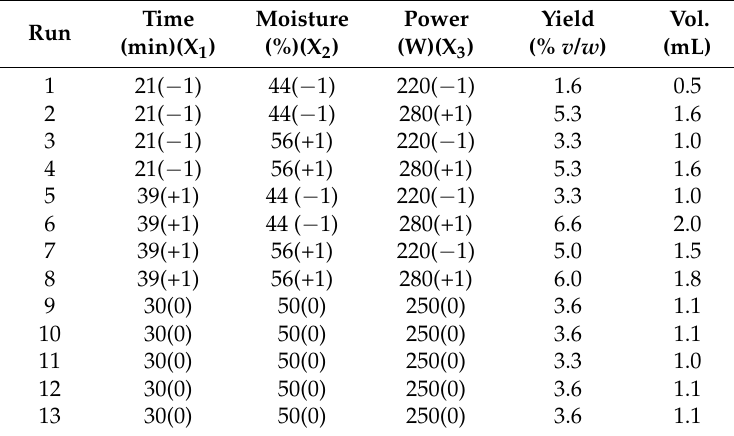
Table 1. Optimisation experimental results of the extraction process yield and volume of volatile oil obtained from P. emarginatus fruits.